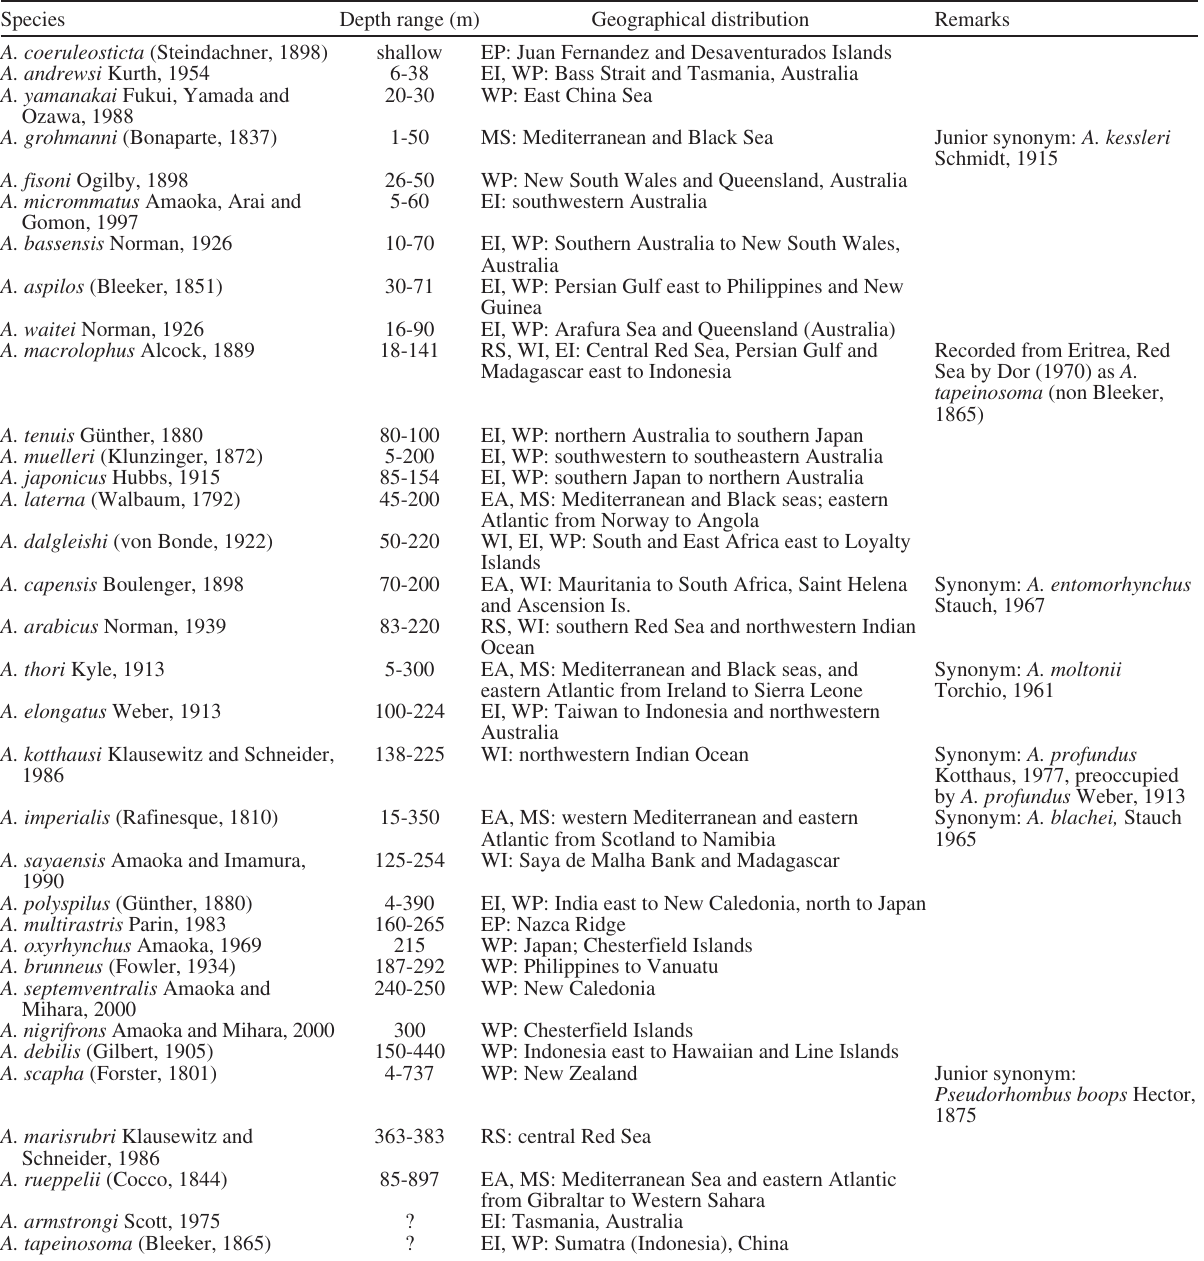
Description . Counts and measurements of the holotype and paratypes listed in Table 2 are part of this description. Body oval, laterally strongly compressed, eyes on the left side of body (the “ocular side”), right side of body without eyes (the “blind side”). Body depth 2.4 (2.3-2.5) in SL [42.3% (40.4%-44.2%) of SL]. Head length 4.0 (4.1-4.3) in SL [24.7% (23.2%-24.2%) of SL]. Snout slightly pointed, completely scaled . Anterior teeth in upper jaw not enlarged, prevomer not enlarged, weakly projecting into mouth cavity. Both nostrils situated anterior to the eyes. Upper orbit diameter 3.4 (3.0-3.3) in head length [7.3% (7.2%-